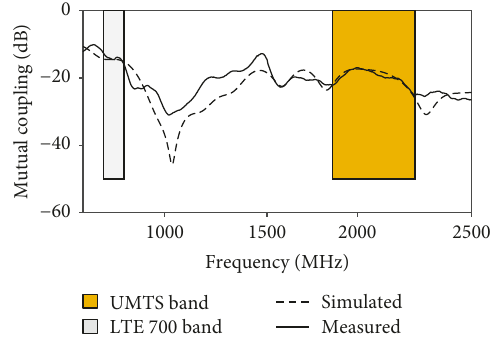
Figure 6: Measured and simulated | S antenna.